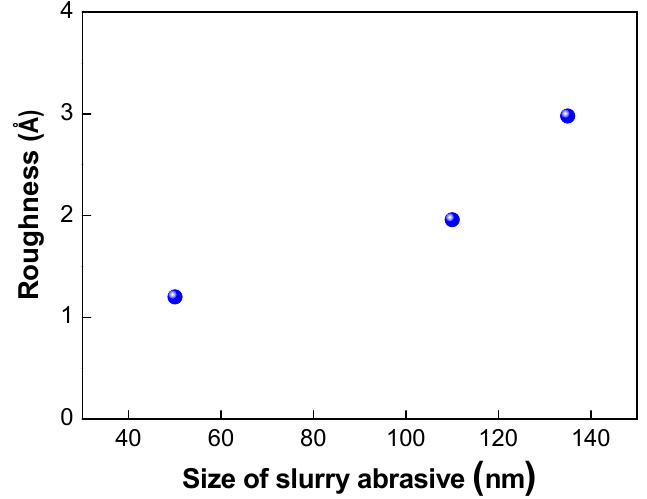
Figure 8. Variation of surface roughness under various slurry abrasive size.